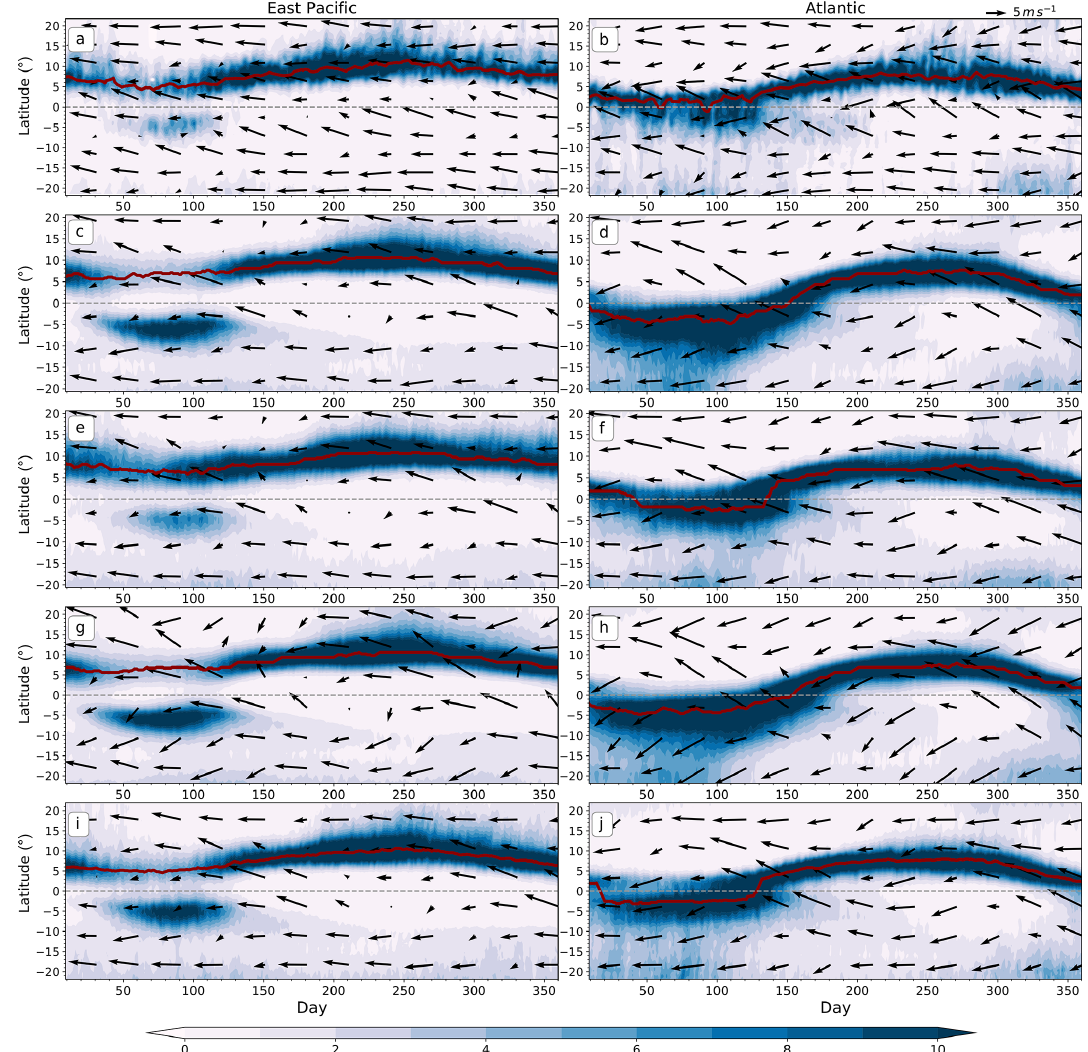
Figure 5. Time–latitude plot of daily mean rainfall (colour contours) and low-level wind speed (850hPa) longitudinally averaged over the (a, c, e, g) east Pacific (150–100 ◦ W) and (b, d, f, h) Atlantic (40–20 ◦ W) oceans. Panels (a, b) show rainfall from TRMM and winds from ERA5, (c, d) the ensemble-mean UKESM-historical, (e, f) GC3 AMIP, (g, h) N96-pi and (i, j) GC3 N216-pi. The red solid line shows the ITCZ as the latitude of maximum